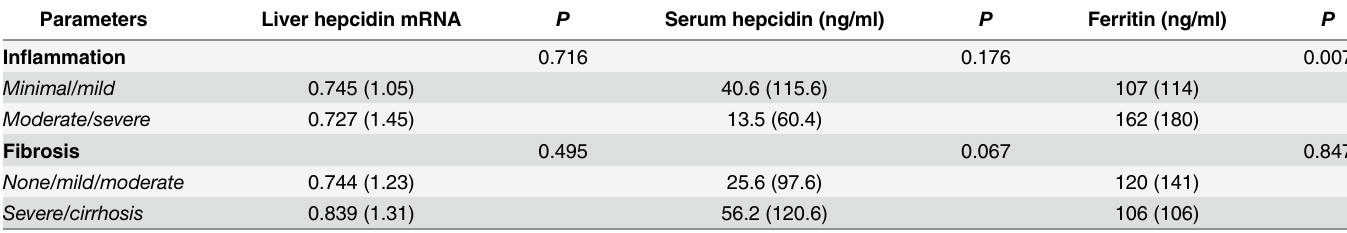
Table 3. Correlations between liver histology, hepcidin and ferritin in all patients.